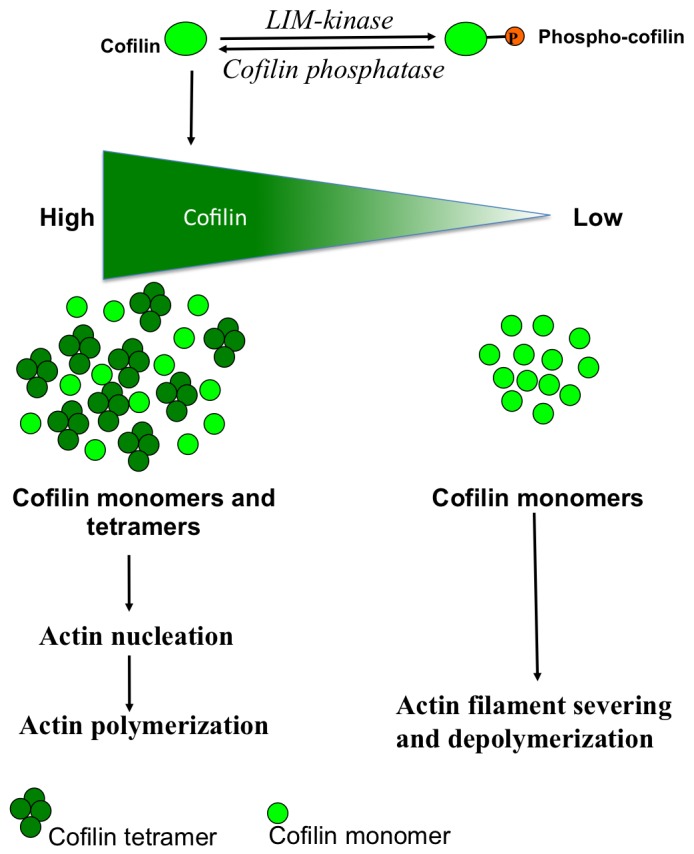
A model explaining how cofilin phosphorylation might regulate cofilin oligomer formation, and thereby its dual function on actin dynamics.